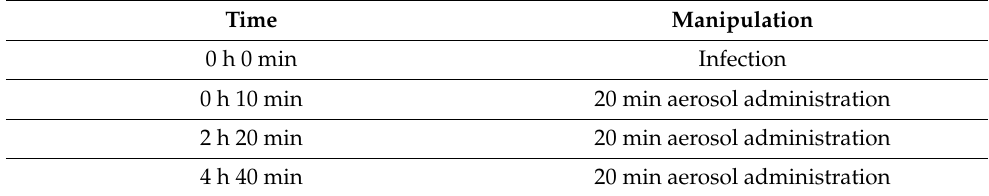
Table 3. Infection–treatment manipulations with mice of Aerosol group.